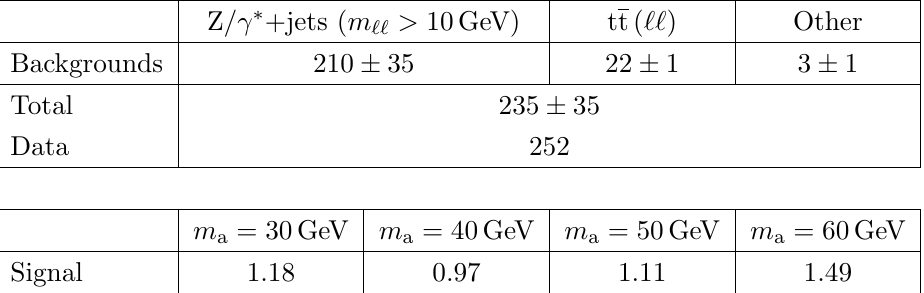
Table 4 . Expected signal and background yields, together with the number of observed events, for the h ! aa ! 2 (cid:22) 2b search, in the range 20 (cid:20) m (cid:22)(cid:22) (cid:20) 70 GeV. Signal yields are evaluated assuming B (h ! aa) = 10% and B (aa ! (cid:22) + (cid:22) (cid:0) bb) = 1 : 7 (cid:2) 10 (cid:0) 3 , with the latter obtained in the context of type-3 2HDM+S with tan (cid:12) =